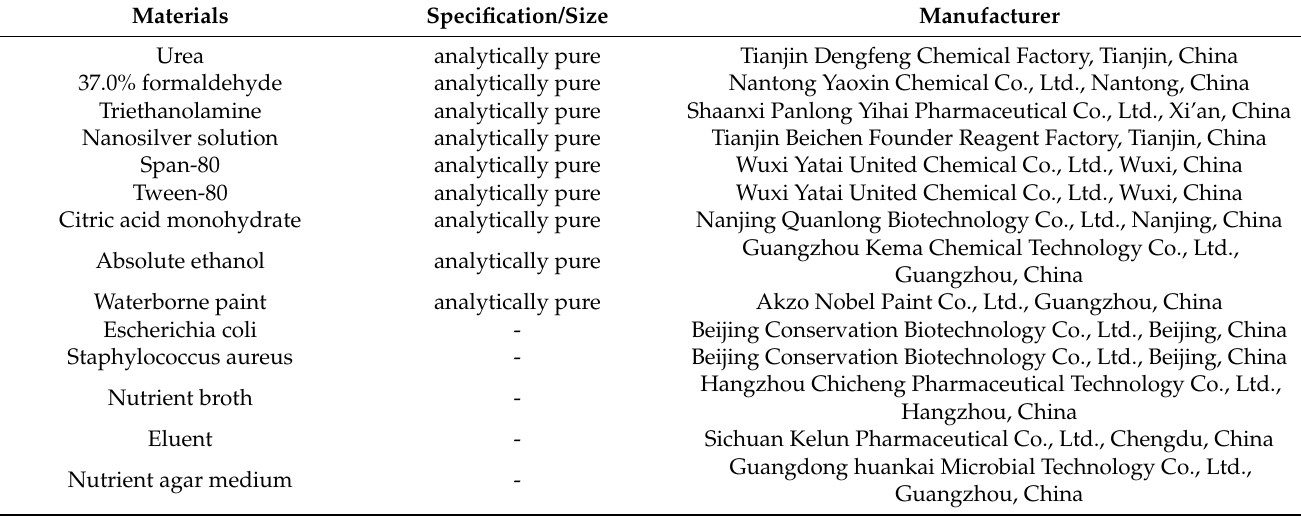
Table 1. The list of the